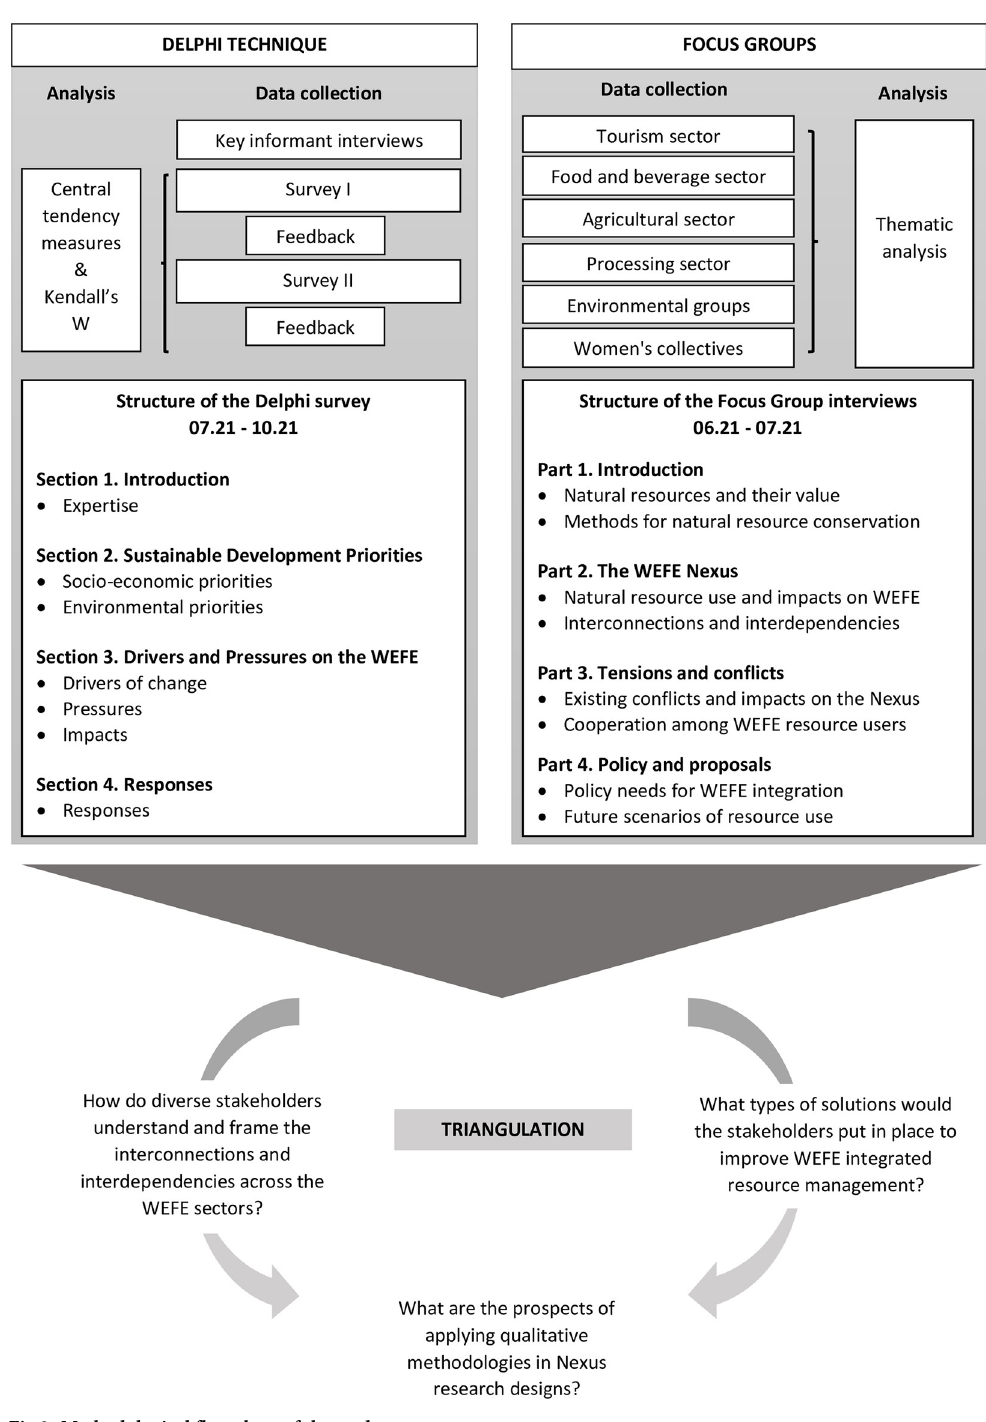
Fig 2. Methodological flow chart of the